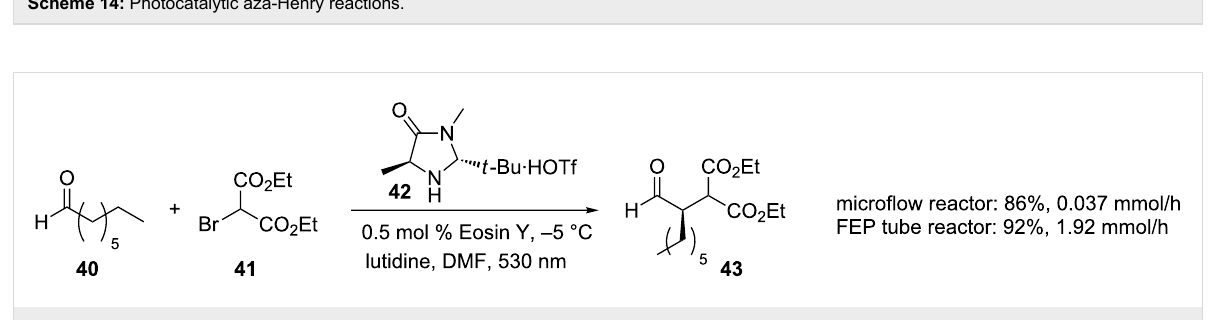
Scheme 15: Photocatalytic α -alkylation of aliphatic